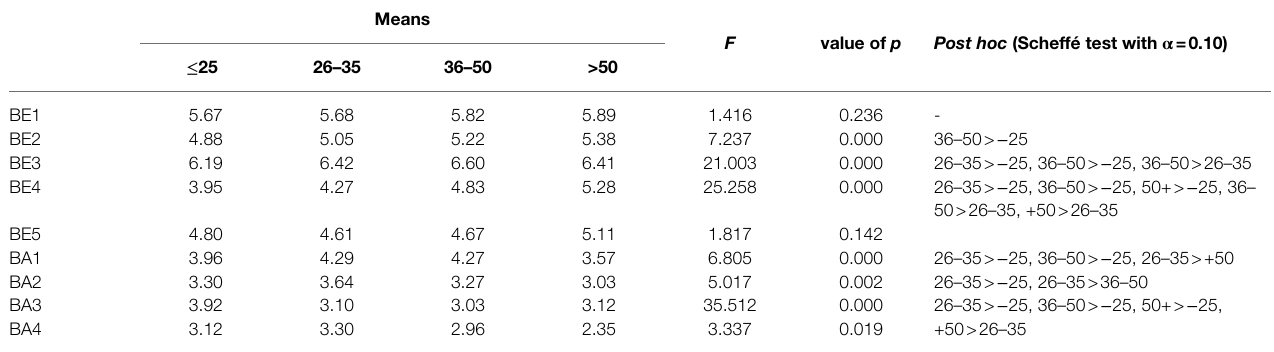
TABLE 5 | Benefit and barrier factor comparison among age groups.